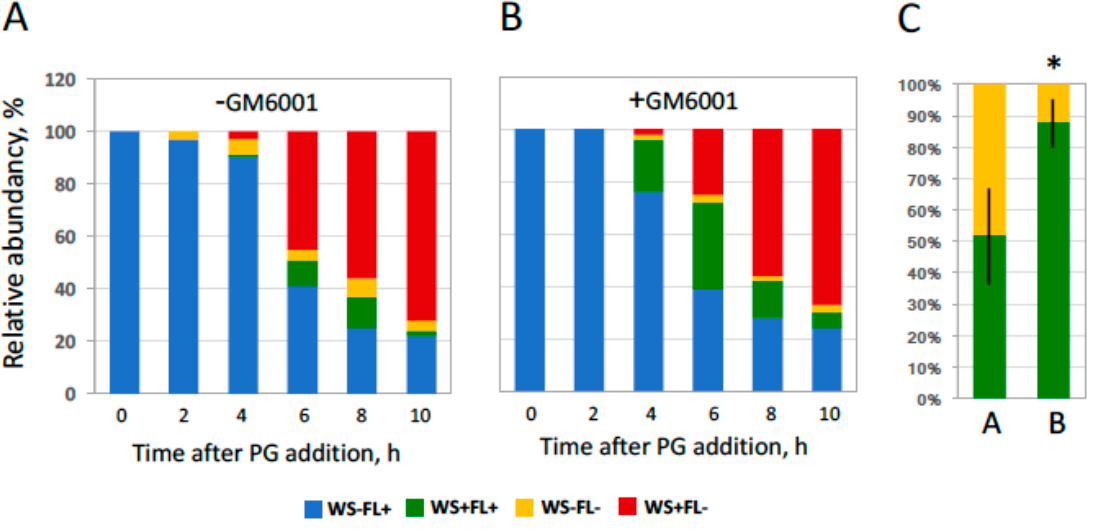
Figure 5. Effect of matrix metalloproteinase (MMP) inhibition on oocyte maturation and defolliculation. ( A , B ) Ratios of the specific oocyte phenotypes, as designated in the legend to Figure 4, in the follicular culture preincubated for 30 min with 5 mg/mL collagenase and treated with PG in the absence or presence of an MMP inhibitor, respectively. The inhibitor was added to the follicular oocytes at a final concentration of 50 µM at the time of PG administration. ( C ) Relative frequencies of the two intermediate phenotypes, WS+FL+ and WS − FL − , under the conditions described for panels ( A , B ). Bars in panel ( C ) represent SD values of the mean obtained in four experiments. An asterisk in panel C indicates statistical significance in the phenotype ratio between A and B ( p < 0.05).